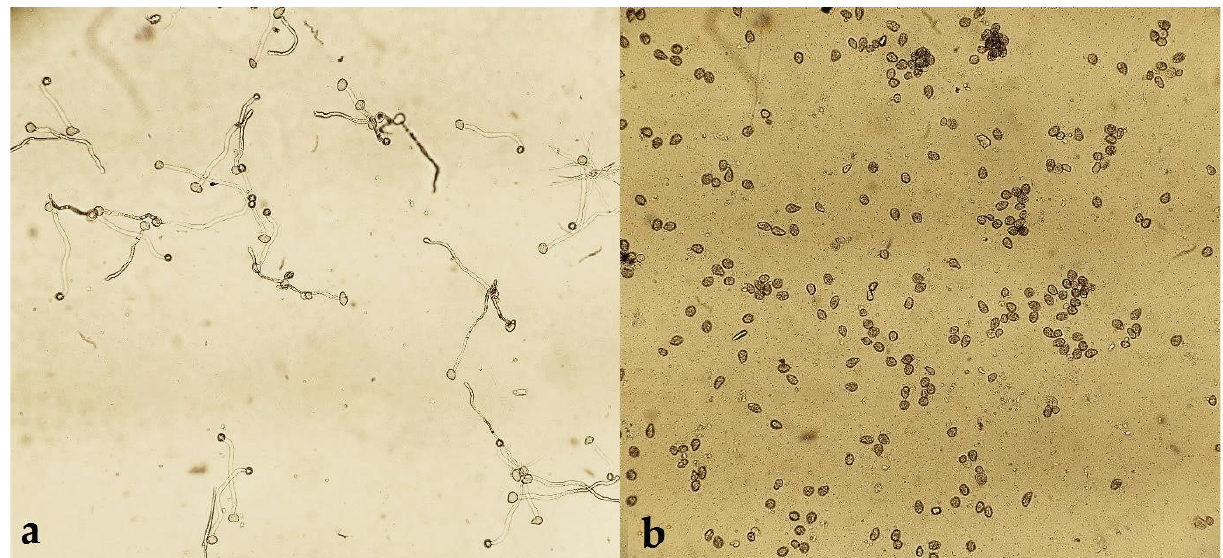
Figure 2. Difference between germinated and inhibited uredospores: ( a ) Germinated uredospores (Negative control); ( b ) non-germinated P. pachyrhizi uredospores (UFV LPP B155-BS + C).